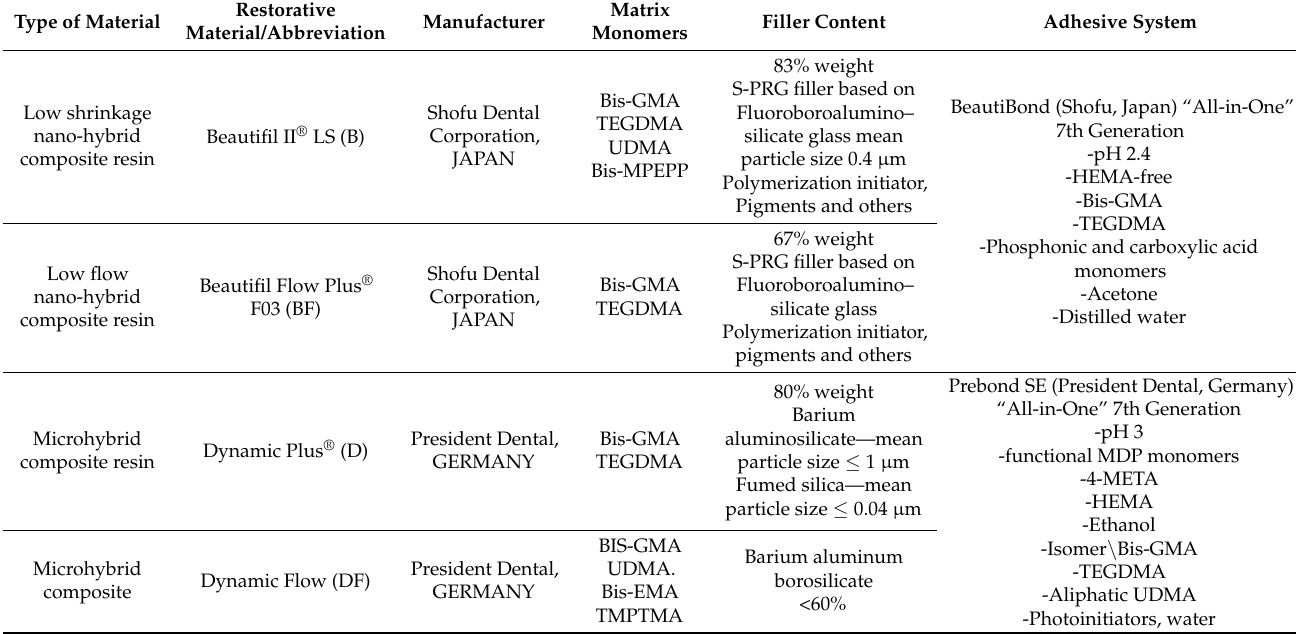
Figure 1. Experimental flow for sections preparation. Two prepared cervical cavities with cervical margin in enamel (arrow) and in cementum (arrowhead), respectively ( a ). Selective etching of enamel margins ( b ). Restoration with Beautifil ® : application of the gingival layer ( c ). Restored tooth coated with nail varnish ( d ). Tooth sectioned in a buccal–oral direction ( e ). Restoration and dental tissues on optical microscopy. The green line is the length (µm) of cervical microleakage and the blue one is the length of the total adhesion interface (40×) ( f ). Table 1. Composition of the materials and of the adhesive system used in the